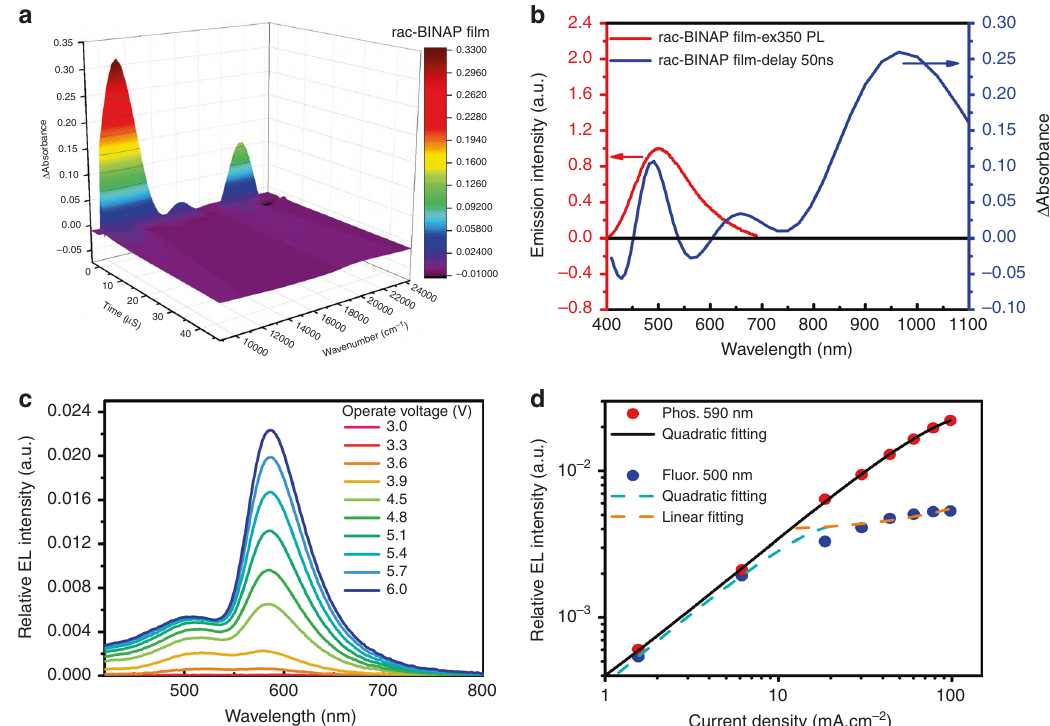
Fig. 5 Kinetic analyses of dual emission in BINAP thin fi lm. a The side view of the absorbance-wavelength plot for the transient UV – Vis character of rac- BINAP in vacuum deposit fi lm on quartz recorded at different delayed time. λ ex = 355 nm. b The absorbance-wavelength plot for the transient UV – Vis character recorded at 50 ns delayed time of rac- BINAP solid fi lm. Also shown is the photoluminescence spectrum (red solid line) of rac- BINAP in solid fi lm. c Relative EL spectra at different operated voltage. d The phosphorescence (Phos., red dot) and fl uorescence (Fluor., blue dot) intensity as a function of the operated current density and the corresponding fi tting